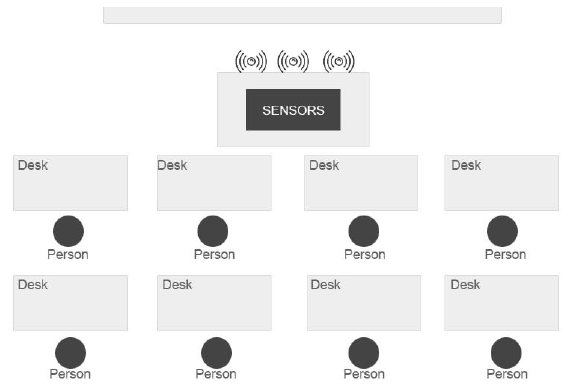
Figure 4 Sensor’s location and the Computer Lab’s seating order